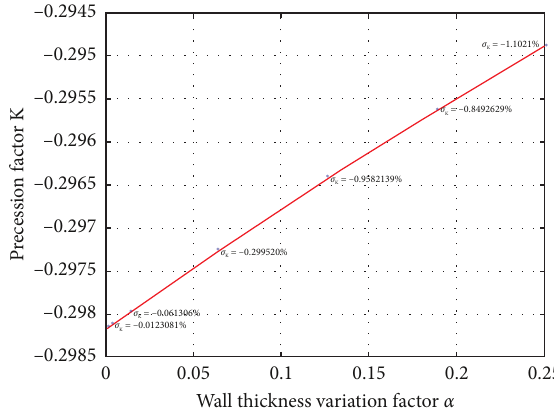
Figure 5: The precession factor with increased thickness of the bottom.